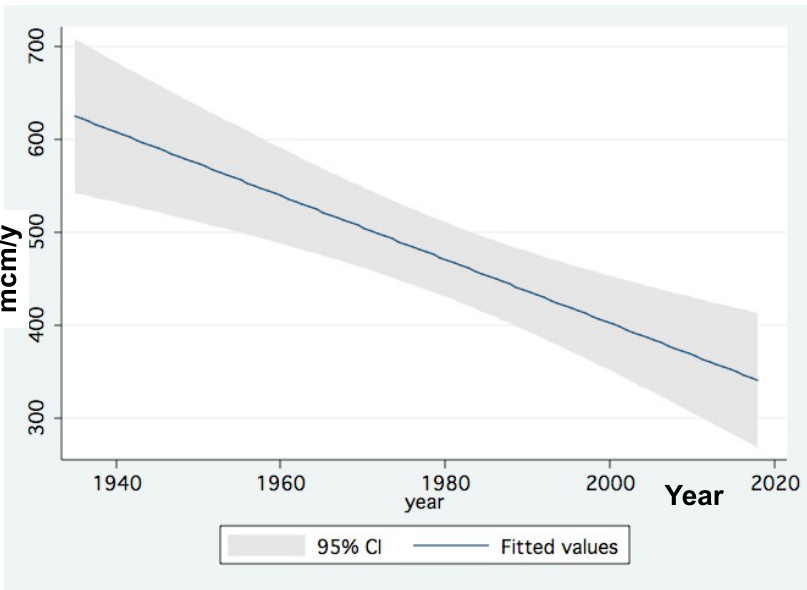
Figure 8. Temporal changes in climate conditions in the Kinneret watershed. Temporal (1940–2018) changes in annual Jordan River discharge (mcm/y) (linear prediction (95% CI).